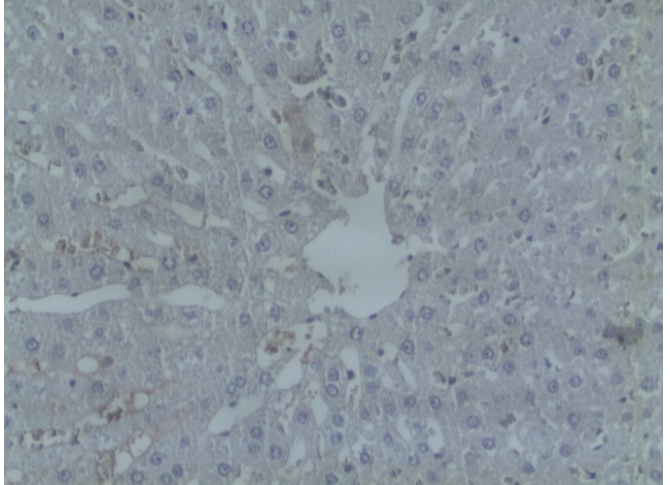
FIGURE 4 - Liver. Photomicrograph displaying rare apoptotic cells identified by brown staining in a rat of the Control (G-1) group. Immunohistochemistry. 200X.